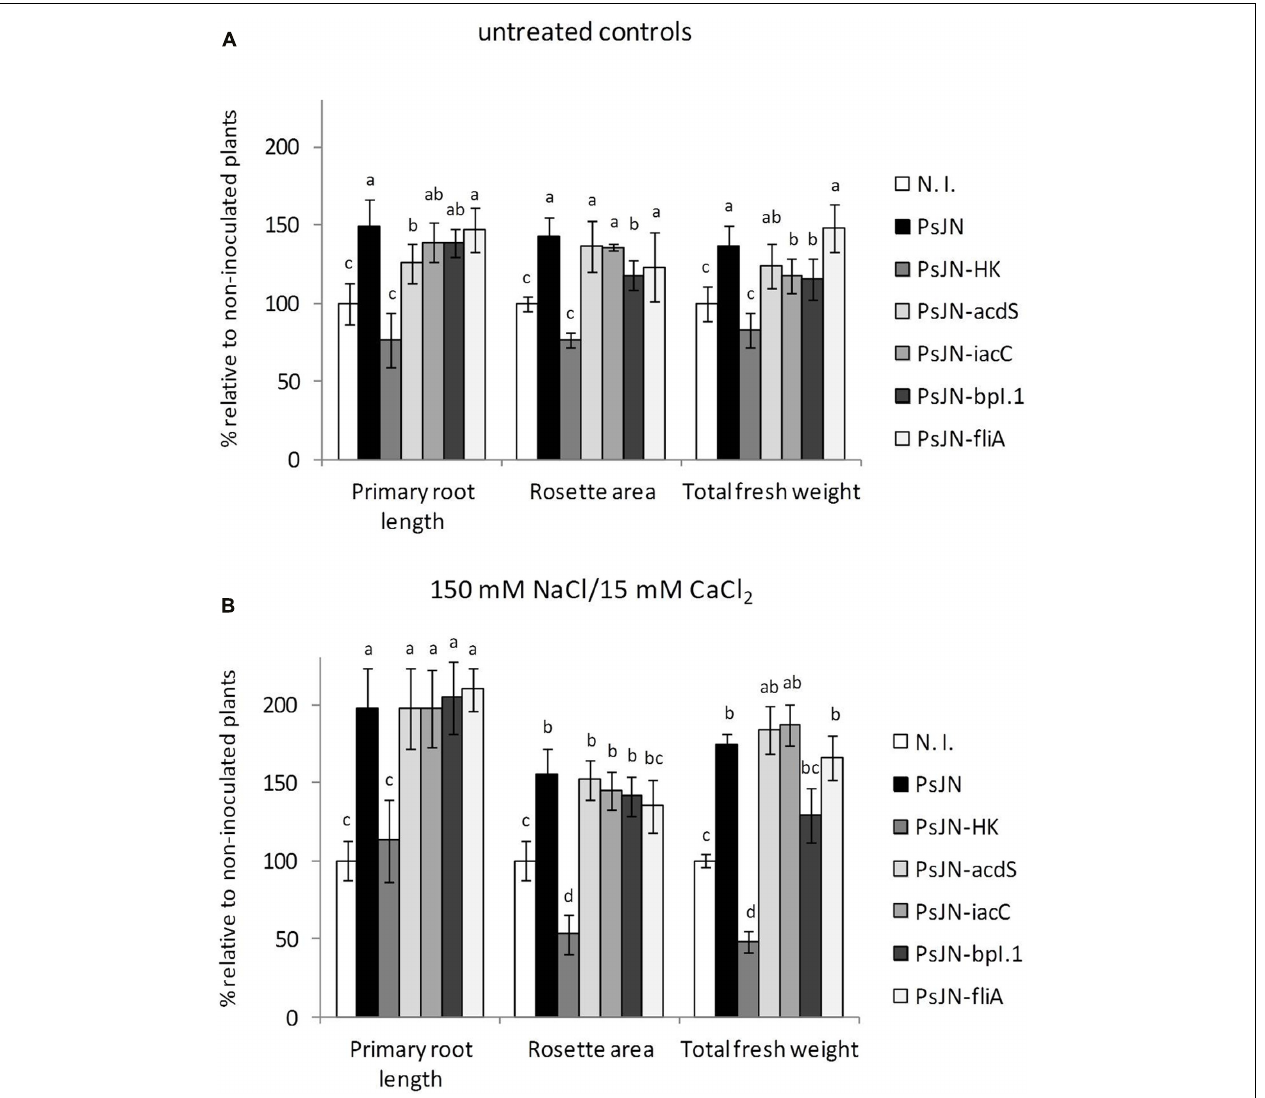
FIGURE 1 | Effect of Paraburkholderia phytofirmans PsJN-derived mutants on growth stimulation of Arabidopsis thaliana plants. Root growth, rosette area and fresh weight of A. thaliana col-0 grown in gnotobiotic in vitro cultures using half strength MS agar medium inoculated with 1 × 10 4 CFU/ml of P. phytofirmans (PsJN), a heat-killed PsJN inoculum (HK-PsJN), the PsJN-derived mutants ( acdS, iacC, bpI.1, or fliA ), or non-inoculated medium (N. I.). Plants were transferred at 11 days after sowing (DAS) to fresh MS 1 / 2 agar with no added NaCl or CaCl 2 (untreated controls) (A) , or MS 1 / 2 agar with 150/15 mM NaCl/CaCl 2 (B) . Growth parameters were registered at 21 DAS. Bars show mean percentage values relative to N. I. plants, and the error bars indicate standard deviations from experiments with 30 plants analyzed for each bacterium and salt treatment. Different letters indicate statistically significant differences among bacterial treatments within each salt concentration for each measured parameter (One way ANOVA Tukey’s HSD tests; p <